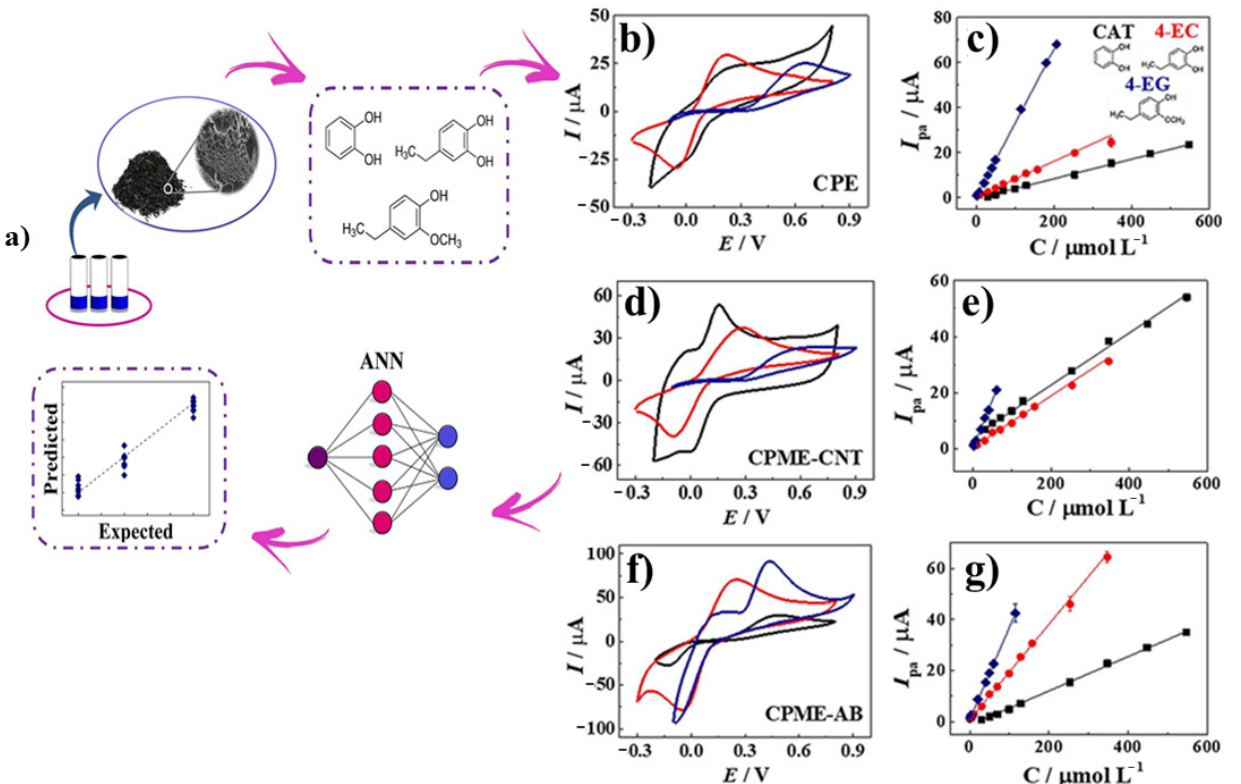
Figure 6. ( a ) Schematic representation of voltammetric electronic tongue-based biochar-modified CPE for phenolic compounds stripping detection. Cyclic voltammograms and analytical curves obtained for catechol (CAT), 4-ethylcatechol (4EC) and ethylguaiacol (4-EG) using CPE, CPME-CNT and CPME ‐ AB ( b – g , respectively).